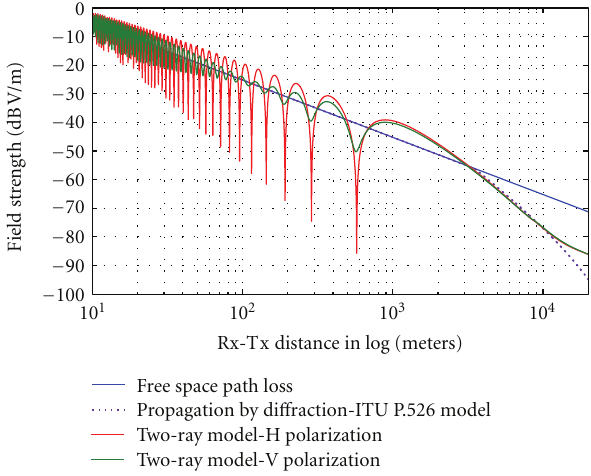
Figure 2: Field strength (dB V/m) versus distance (log